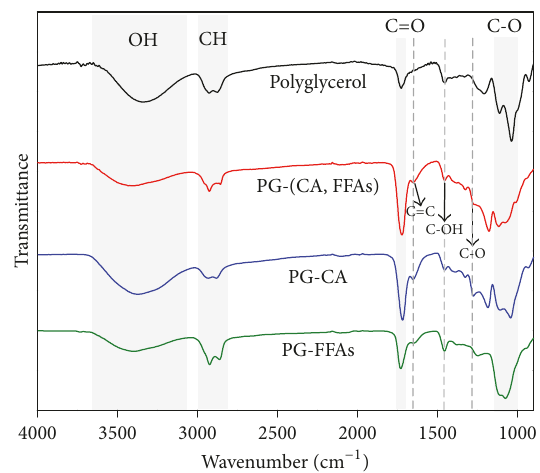
Figure 2: FTIR spectra of glycerol-derived polyglycerol and polyglycerol-based hydrogels. The main peaks associated with the structures are